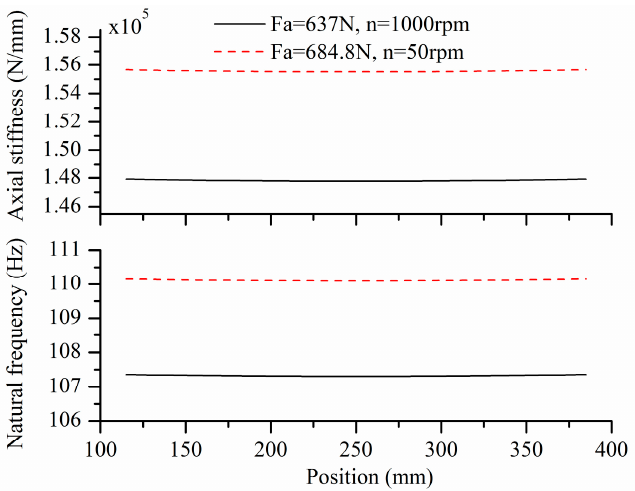
Figure 28. The theoretical value of the axial stiffness and natural frequency of feed system.